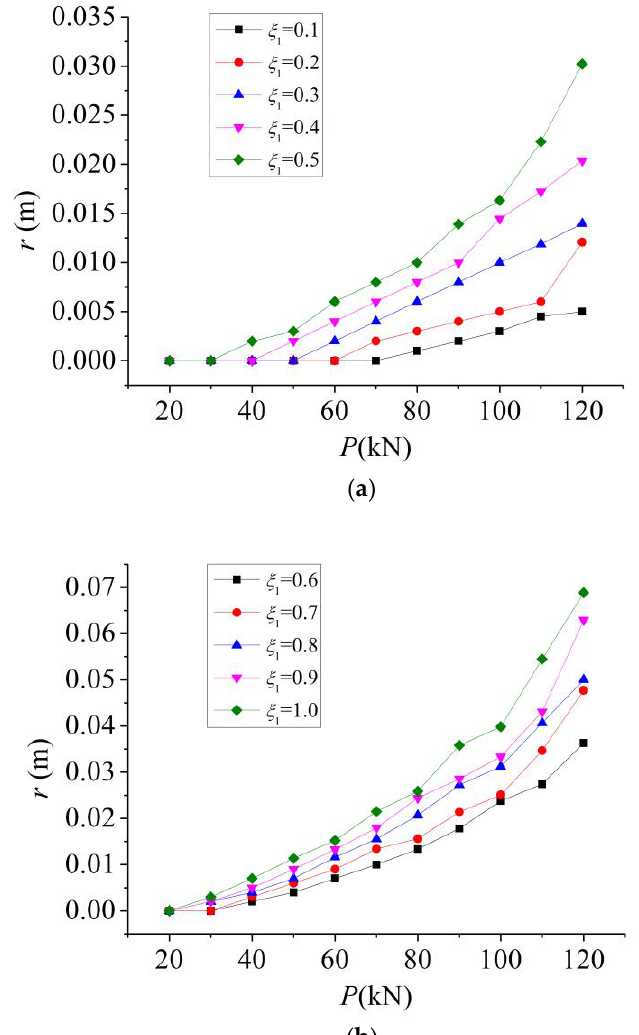
Figure 18. Sizes of plastic zone for different external loads. ( a ) Sizes of plastic zone for different external loads when ξ 1 = 0.1 − 0.5, ( b ) Sizes of plastic zone for different external loads when ξ 1 = 0.6 −